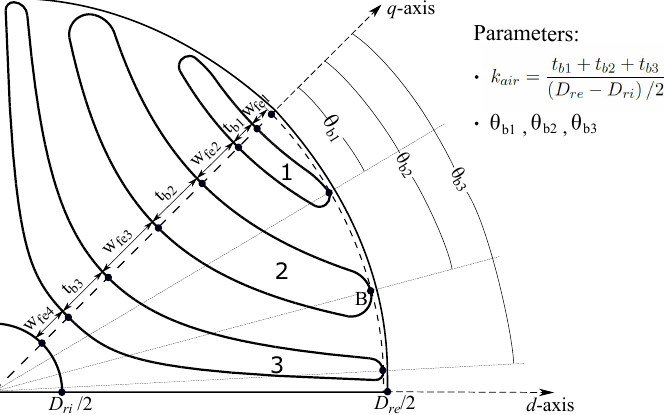
Figure 3. Parameters definition of a SynRM rotor with three barriers per